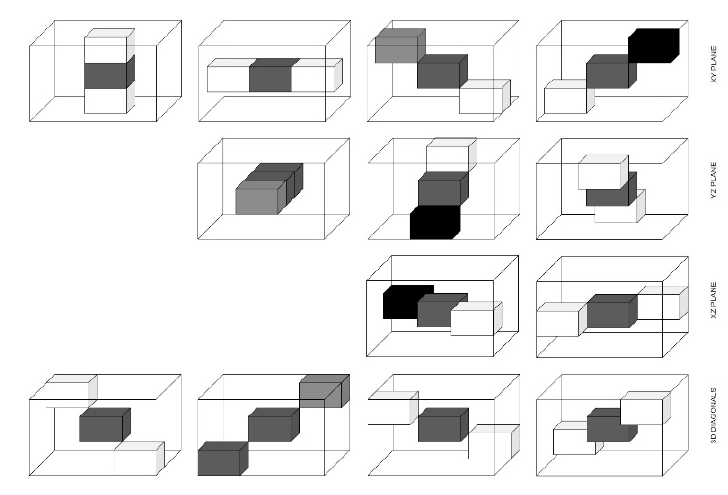
Figure 6. 13 directions for 3D GLCM. Table 3. GLCM features and their